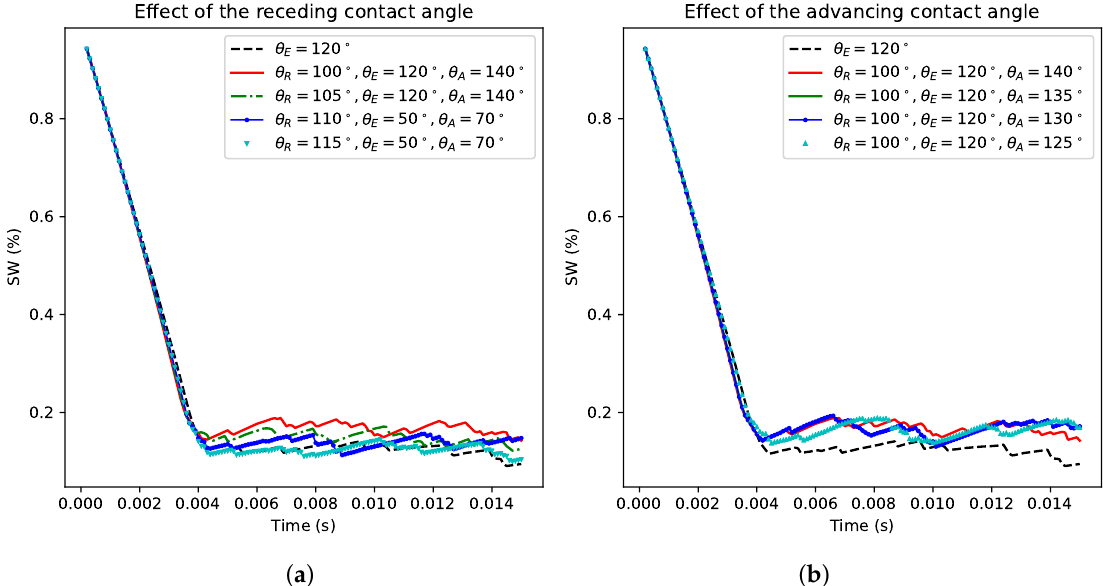
Figure 11. Sensitivity to the contact angles at the oil-wet configuration for the receding ( a ) and advancing ( b ) contact